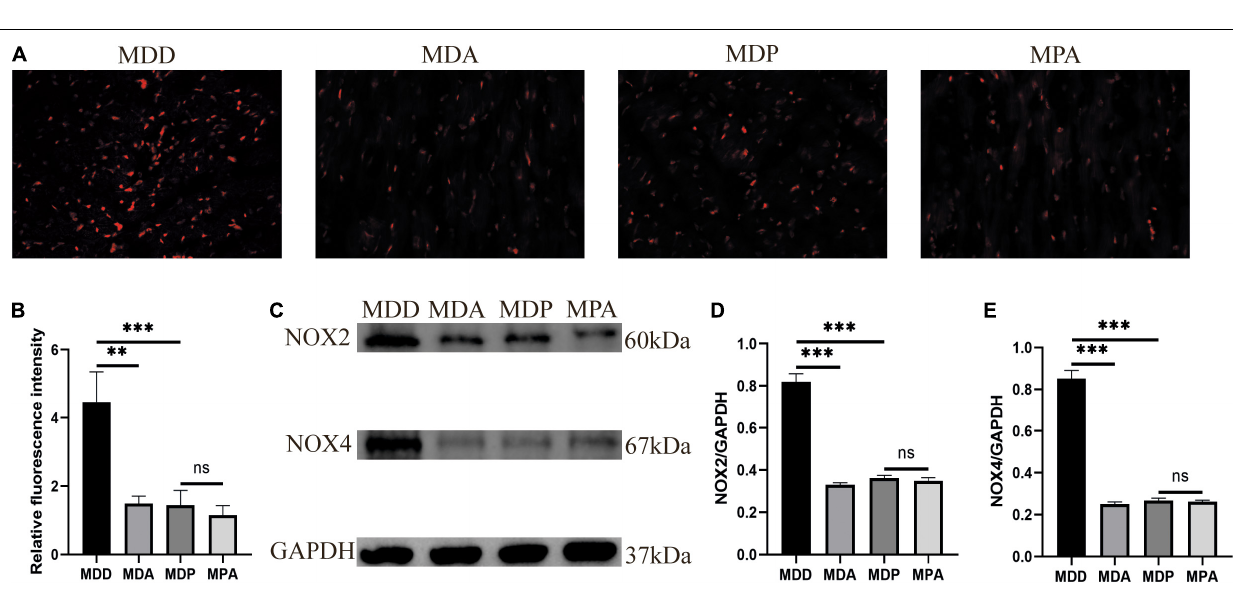
Frontiers in Cardiovascular Medicine |